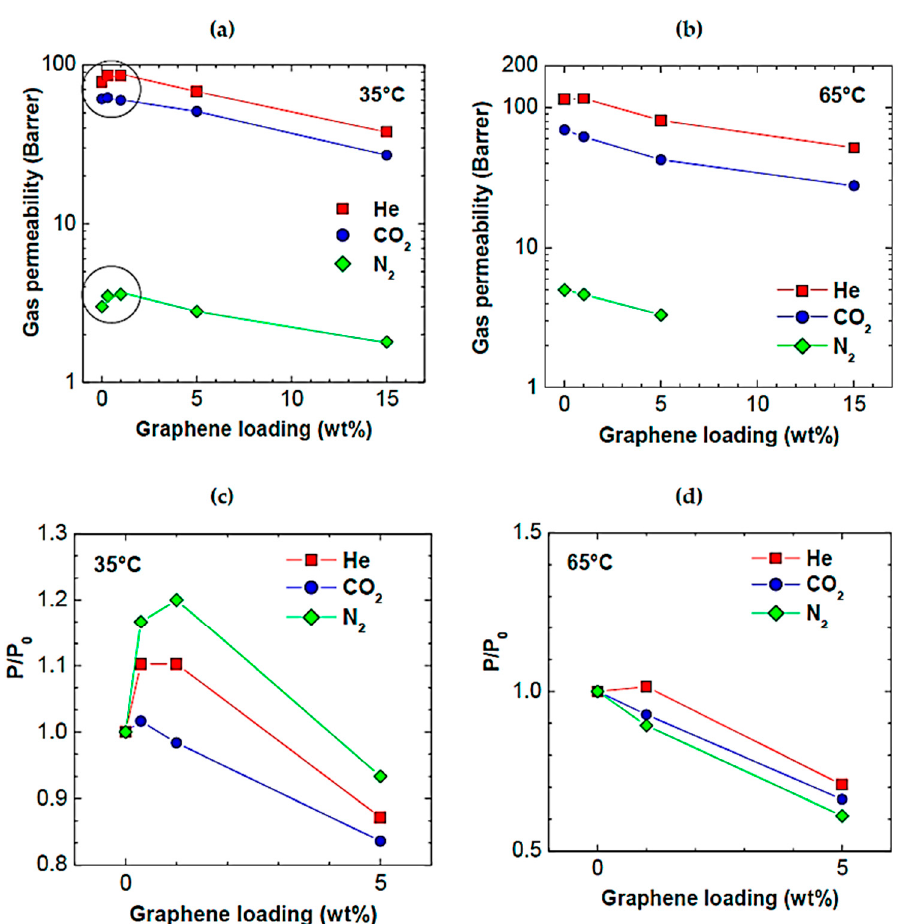
Figure 13. Gas permeability apparatus (operated from high vacuum up to 70 bar pressure condi- tions) [126]. Reproduced with permission from Elsevier.